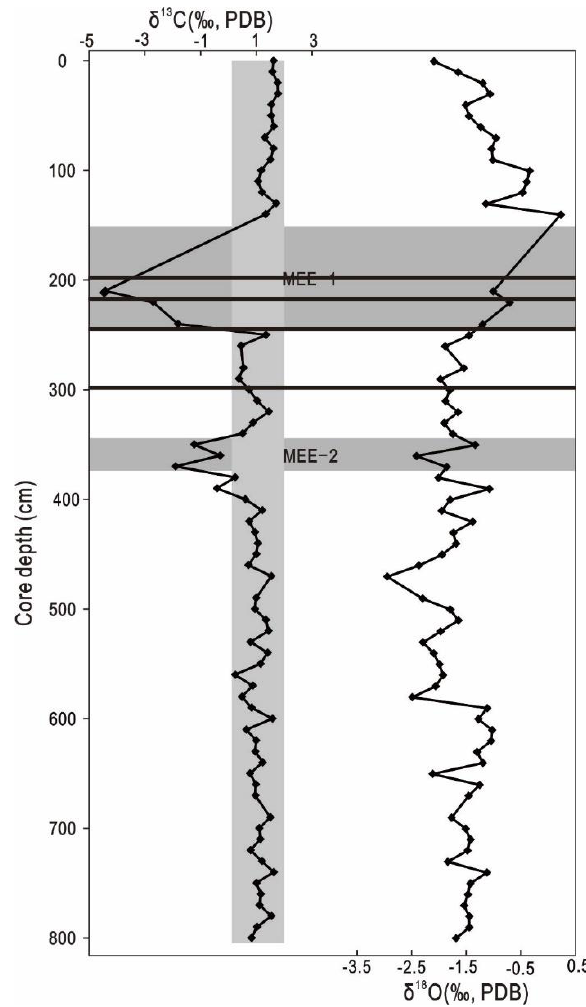
Figure 4. Stable isotopic compositions of planktonic foraminifera Globigerinoides ruber in core 2PC. Two major methane emission events (MEEs) were found. The black rectangles indicate three depth intervals of authigenic gypsum crystals and pyrite (199–200, 221–222, 249–250 and 299–300 cm bsf). The gray rectangle indicates the range of planktonic foraminifera 13 C of typical marine settings [60– 62].